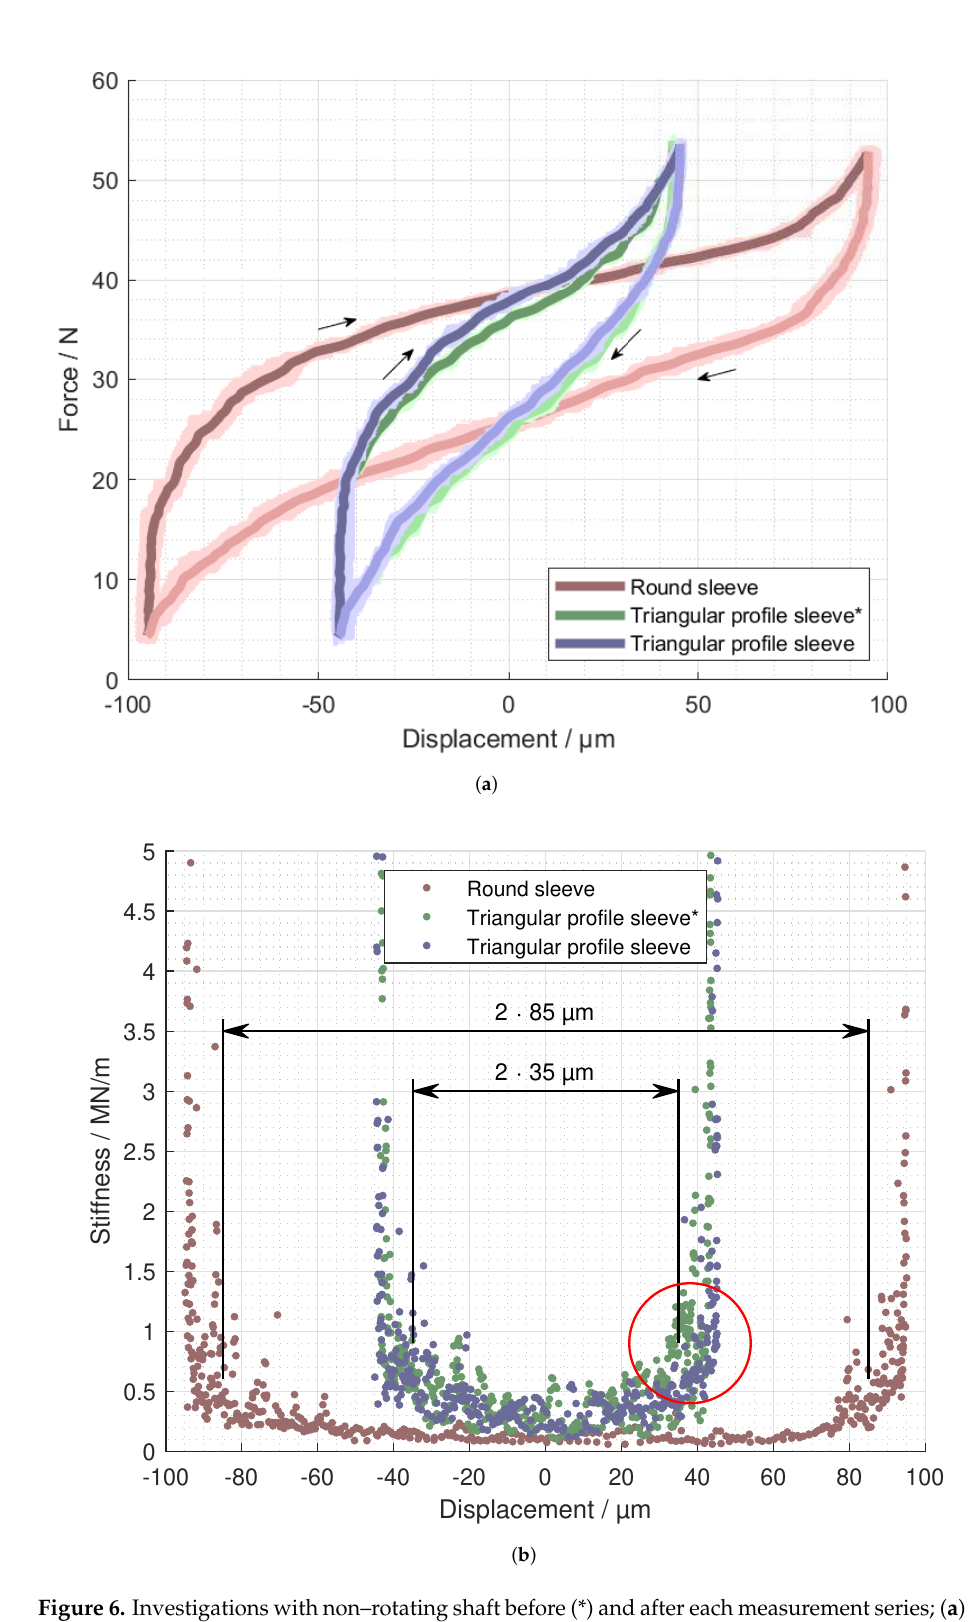
Figure 6. Investigations with non–rotating shaft before (*) and after each measurement series; ( a ) force vs. displacement: the relation of the pronounced hysteresis to the path direction is indicated by arrows. The light shadows behind the averaged curves are the seperated hysterese curves. ( b ) stiffness vs.